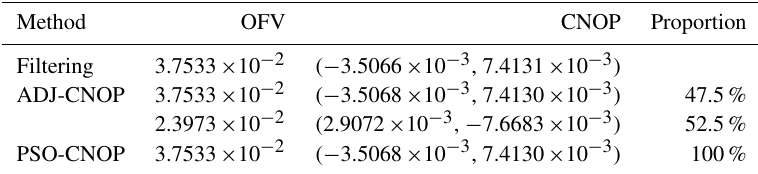
Figure 4. The distributions of OFVs at the prediction times 6 (cid:49)t (left) and 13 (cid:49)t (right), in which dots a and b are the global and local maximum points. Table 1. Statistical analysis of CNOPs produced by different methods at 6 (cid:49)t